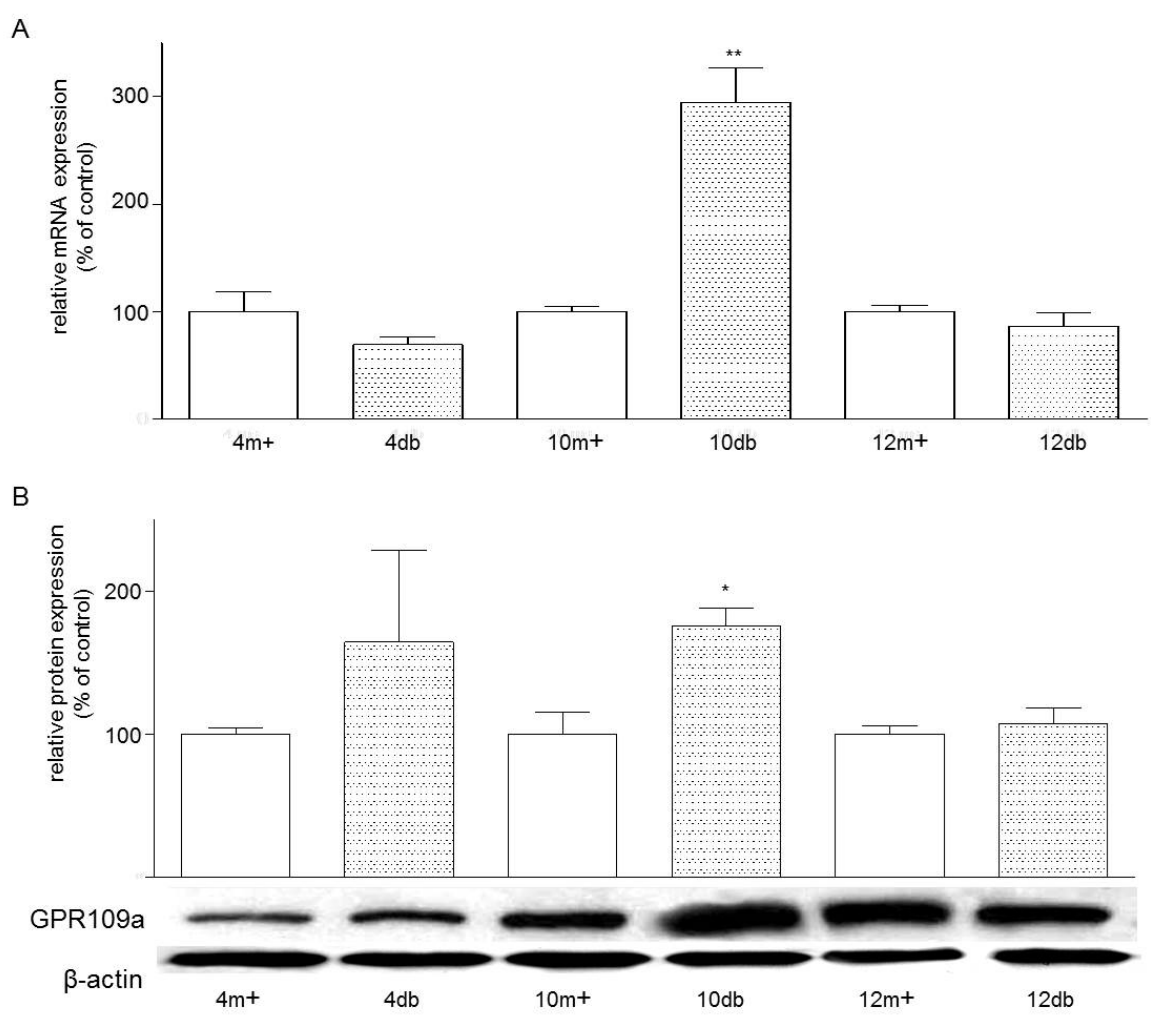
Figure 1. ( A ) Effects of age and Type 2 Diabetes Mellitus (T2DM) on the mRNA expression of GPR109a in jejunal mucosa. Mouse mRNA abundance was determined by real-time PCR using jejunal mucosa and data were calculated as the percentage of their corresponding m+ non-diabetic controls. All results are expressed relative to enterocytes of non-diabetic rats, and are given as mean ± standard error of the mean (SEM), n = 3–4; 10 db vs. 10 m+, ** p < 0.01; ( B ) Effects of age and T2DM on the protein expression of GPR109a in jejunal enterocytes. Western blot analysis showing the relative expression of GPR109a in homogenates of enterocytes prepared from jejuna of m+/db and db/db mice of 4, 10 or 12 weeks of age. Data were calculated as the percentage change compared to their corresponding m + non-diabetic control. Results are expressed as means ± SEM, n = 3–5, 10m+ vs. 10 db, * p < 0.05. 4m+, 8m+, 10m+ and 12m+ represent 4-, 8-, 10- and 12-week-old m+/db mice respectively; whereas 4 db, 8 db, 10 db and 12 db represent 4-, 8-, 10- and 12-week-old db/db mice, respectively.